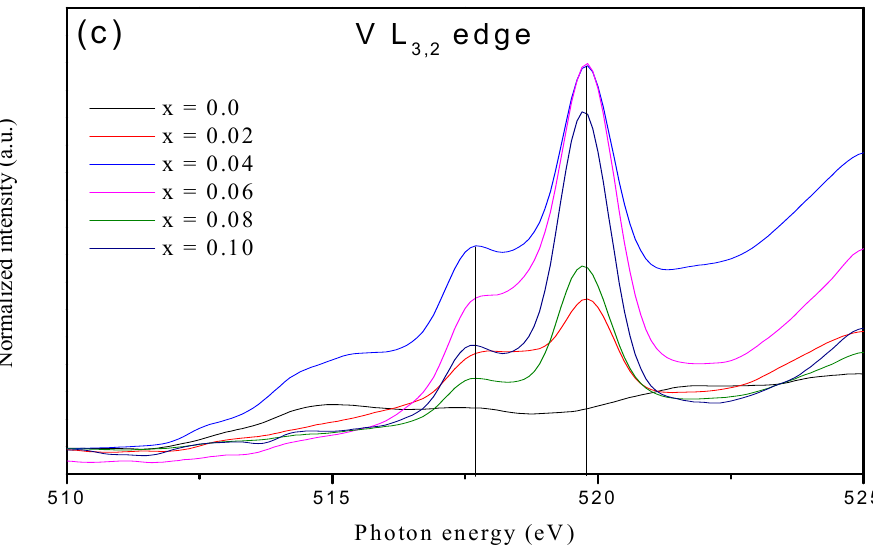
Figure 3. X-ray Absorption Near Edge Spectroscopy (XANES) spectra of ( a ) Zn L 3,2 -edges at different concentration of V contents, ( b ) O K-edge for different concentration of V contents, ( c ) V L 3,2 -edge for different concentration of V contents.